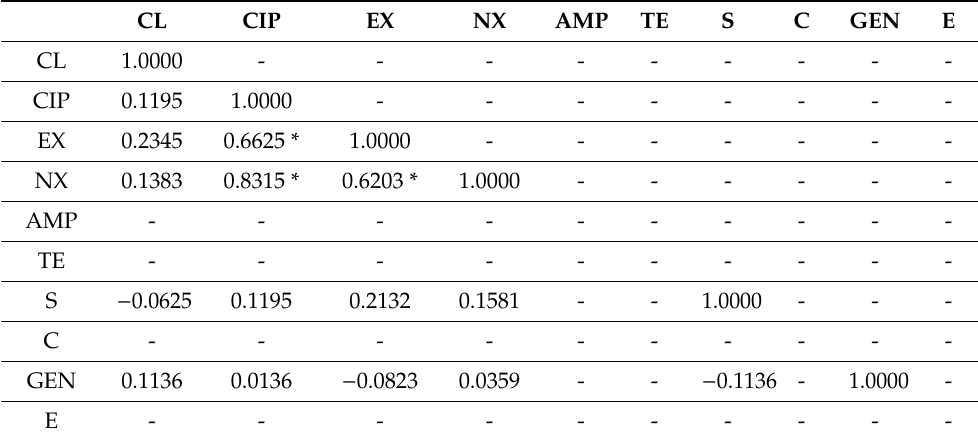
Table 6. Pairwise correlations between resistance to antimicrobials of APEC isolated from layer chickens ( n = 36) AB . CL CIP EX